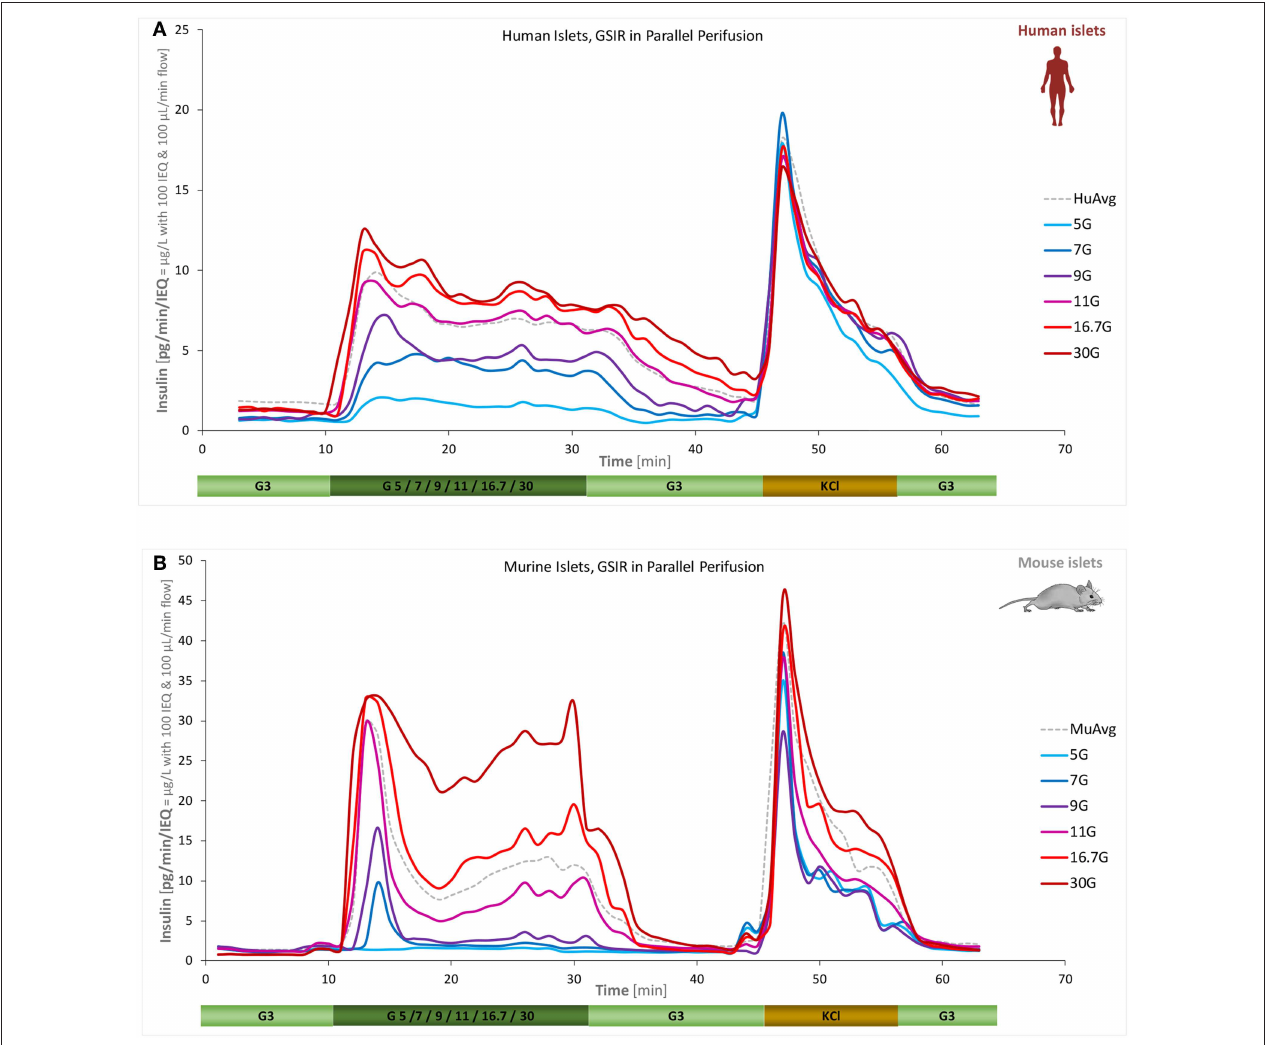
FIGURE 3 | Concentration dependence of insulin secretion in murine and human islets. Summary of experimental data for free human (A) and murine islets (B) perifused using standard equipment and parallel stepwise incoming glucose stimulations (3mM → 5/7/9/11/16.7/30mM → 3mM as indicated; plus 10min KCl and 10min low; corrected to ∼ 100 IEQ per chamber; n = 3–12 per group). Averages of all data obtained in our labs for the G3 → G11 protocol are included as dashed gray lines for